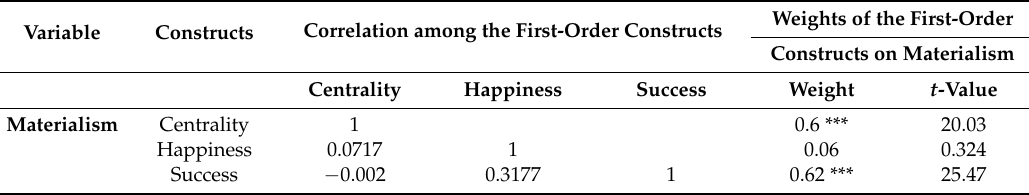
Table 2. Validity of second-order formative and first-order reflective construct of